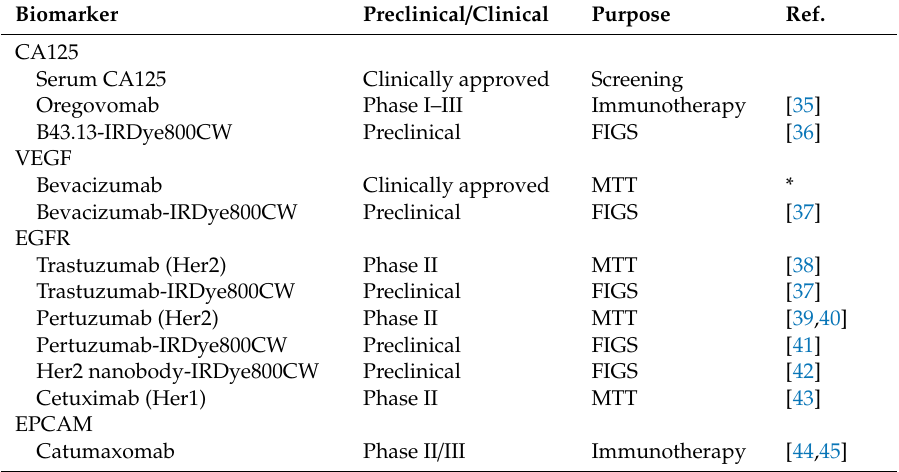
Table 1. Molecular biomarkers of ovarian cancer. The present and